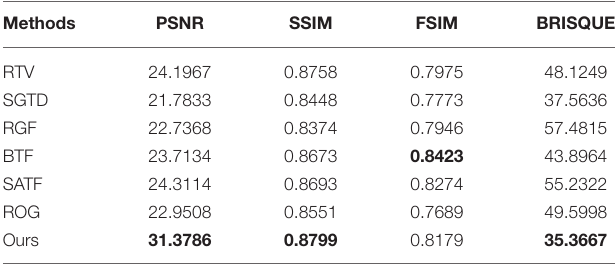
TABLE 1 | Comparison of the mean values of the objective evaluation indexes.